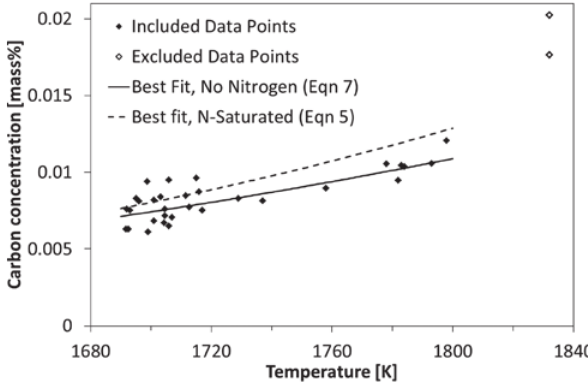
Fig. 4: The re-evaluated best fit equation for the solubility of carbon in liquid silicon for the pure Si–C-system, together with the included and excluded data points